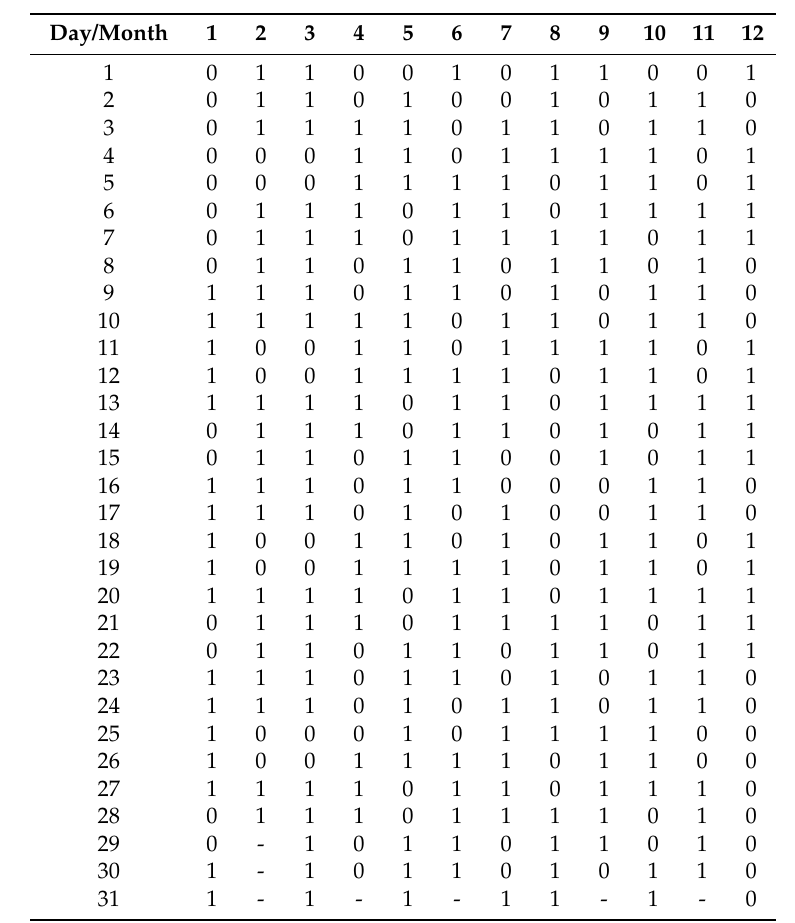
Table 1. Charging calendar considered in the present study. Days where the EV charging service is available are represented by 1, and by 0 otherwise. EV: Electric